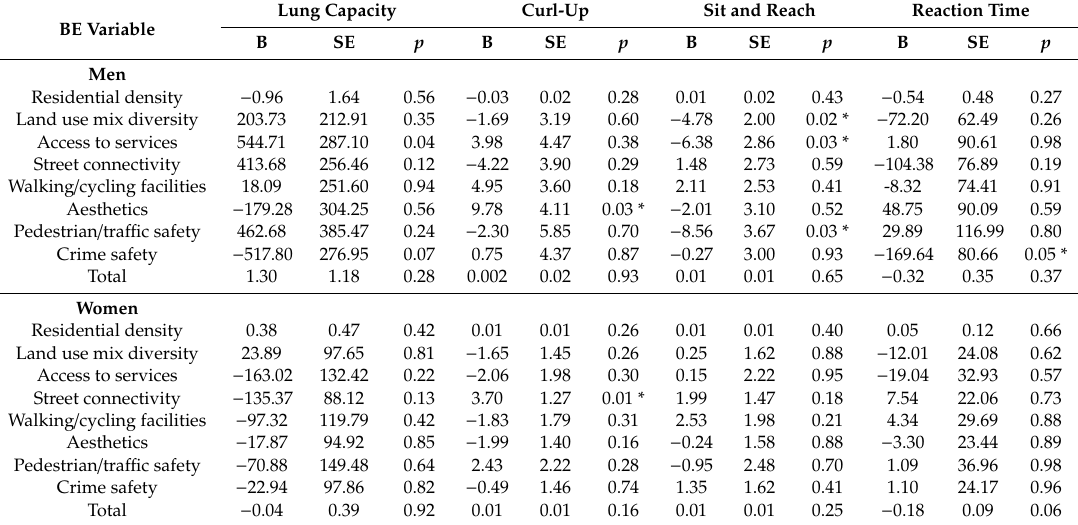
Table 5. Association c between BE and lung capacity, curl-up, sit and reach, and reaction time in di ff erent PA